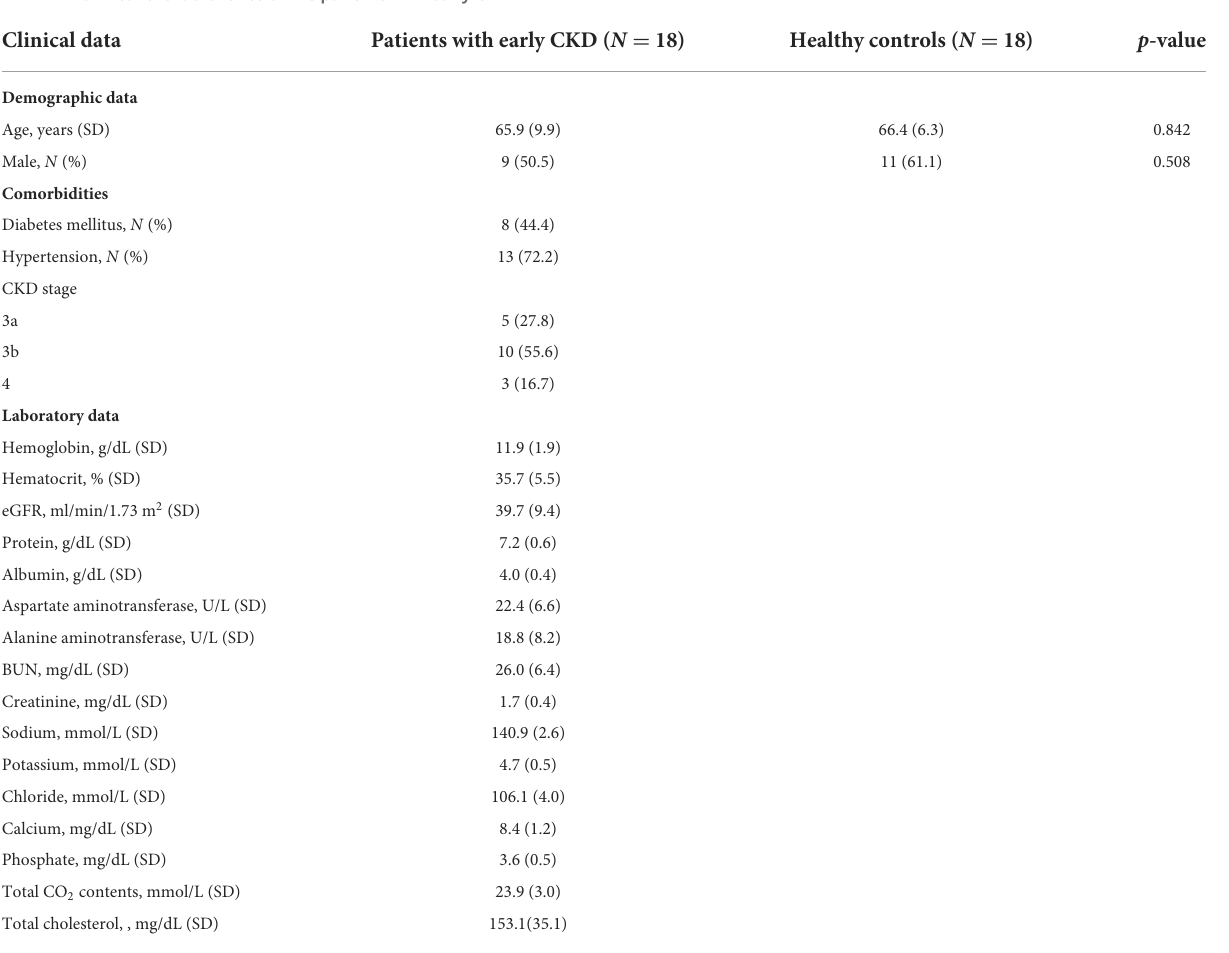
TABLE 1 Clinical characteristics of the patients with early CKD. Clinical